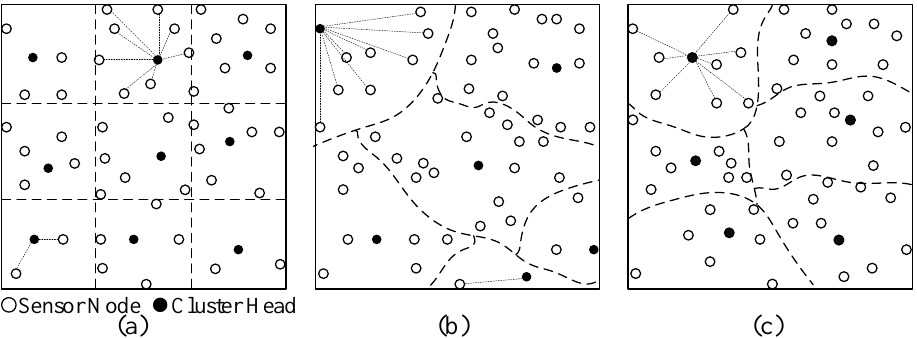
Simplified diagram of sensor node clustering: ( a ) grid-based clustering method, ( b ) low-energy adaptive clustering hierarchy (LEACH)-based clustering method, and ( c ) adaptive sensor node clustering method for determining the number of clusters and grouping the number of sensor nodes into clusters